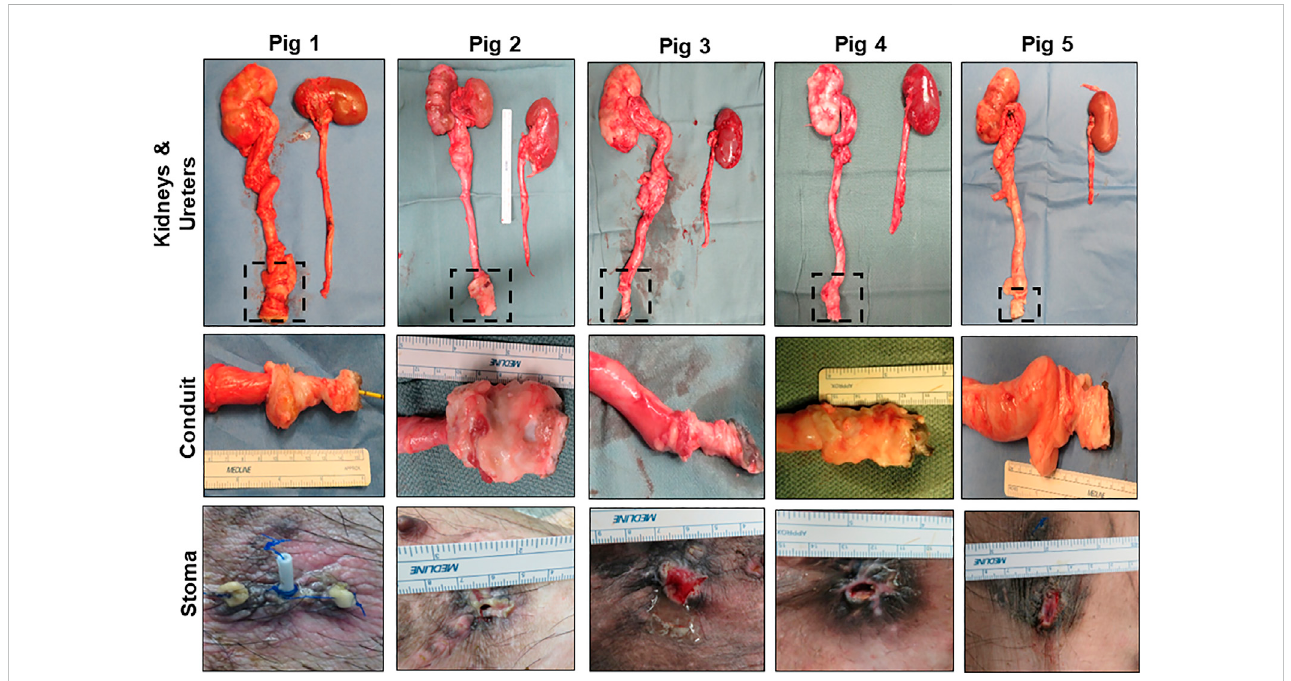
FIGURE 3 Necropsy assessments of neoconduits and reconstructed collecting systems. Top row: Photomicrographs of collecting systems and neoconduits (boxed)inPigsoneto fi vefollowing3monthsofbiomaterialimplantationaswellasparallelnon-operatedcontroluretersandkidneys.Secondrow:Magni fi ed axial view of neoconduits from initial graft regions at harvest. Bottom row: Stomal ori fi ce at 3 months